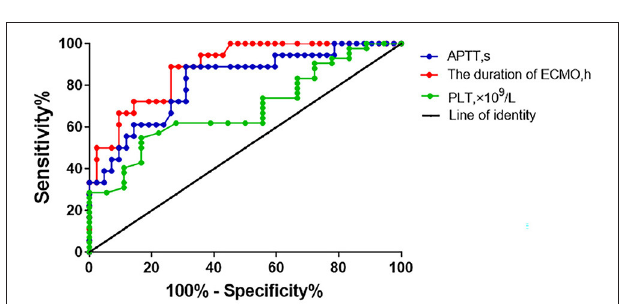
FIGURE 2 | ROC curves of logistic